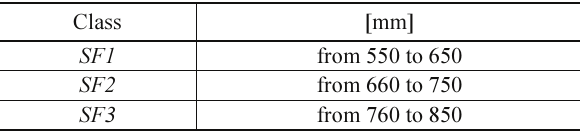
Table 1. Slump-Flow classes (European Project Group 2005)